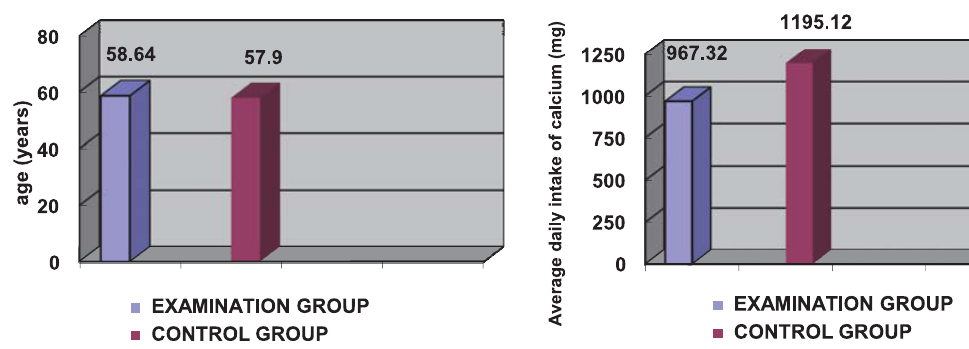
FIGURE 1. The average age of women without estrogen de fi ciency in menstrual history. t = 0.746, no statistically sig- ni fi cant